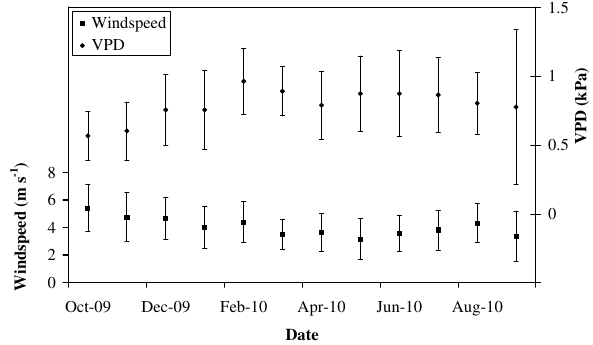
Fig. 2. Climatic conditions at the Mfabeni Mire including maximum and minimum air temperature ( ◦ C), rainfall (mm) and daily solar radiant density (MJm − 2 ) from October 2009 to September 2010.